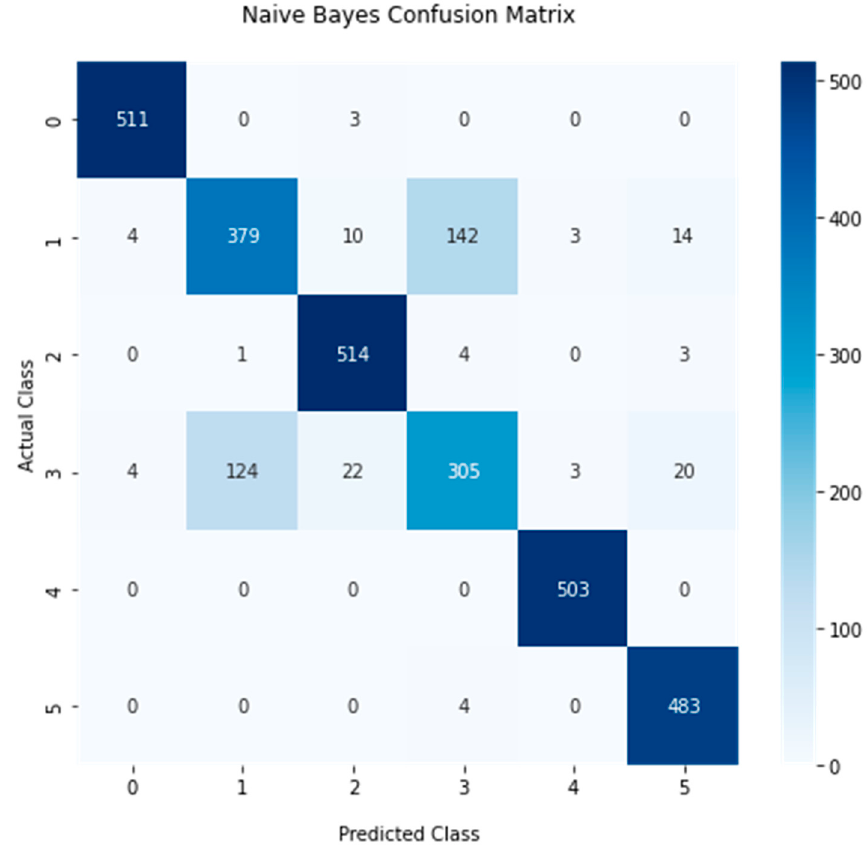
Figure 15. Confusion matrix of Naive Bayes.